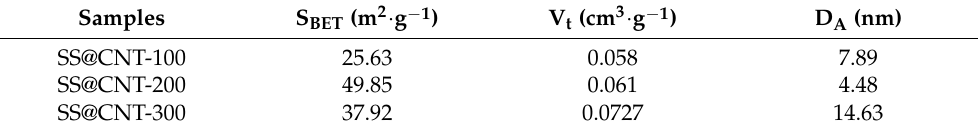
Figure 13. The particle size distribution ( a ) and cumulative size distribution ( b ) of SS@CNTs synthesized under different C 2 H 2 flow rates. Table 7. The parameters of the TGA of the CNTs synthesized under different C 2 H 2 flow rates.